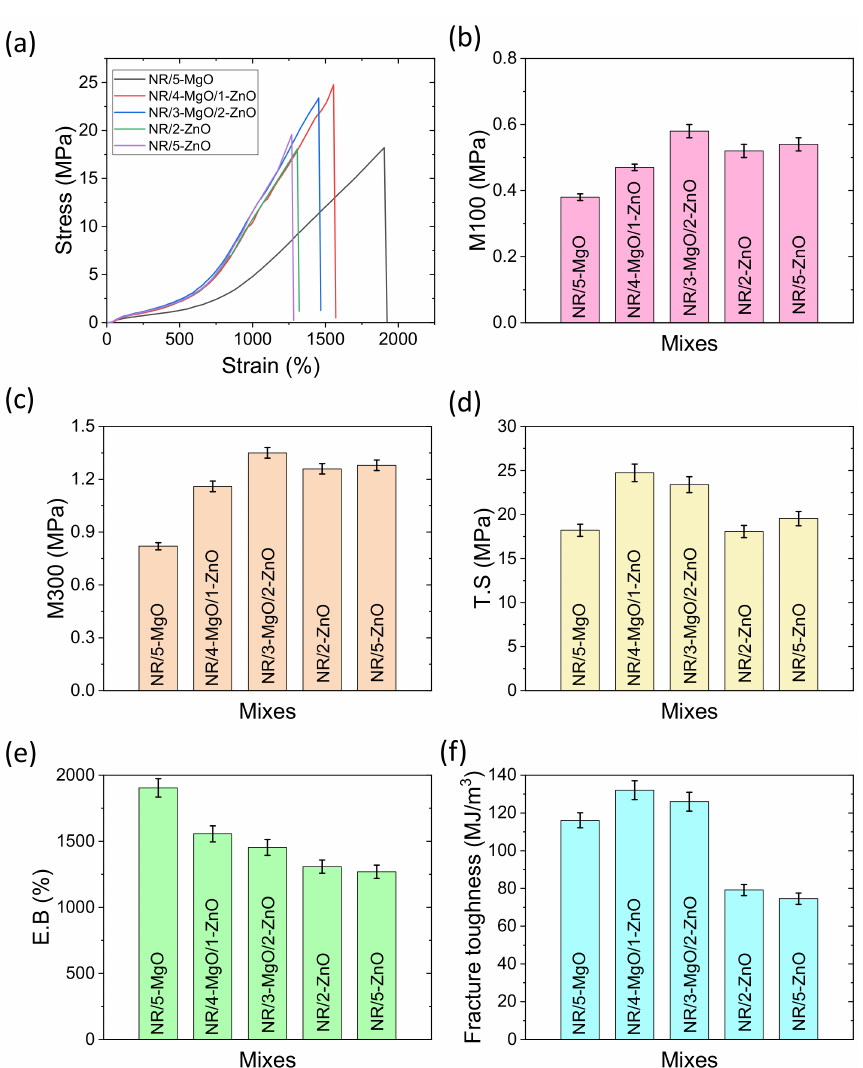
Figure 6. Tensile mechanical properties of vulcanized rubber; ( a ) stress-strain, ( b ) M100, ( c ) M300, ( d ) T.S, ( e ) E.B, and ( f ) fracture